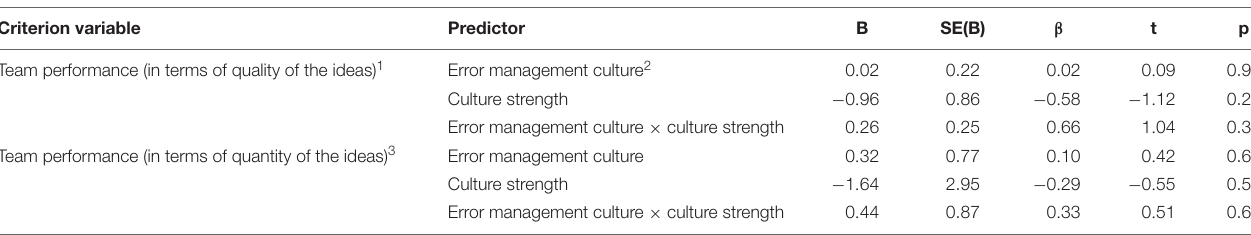
TABLE 8 | Moderation analysis for culture strength in Study